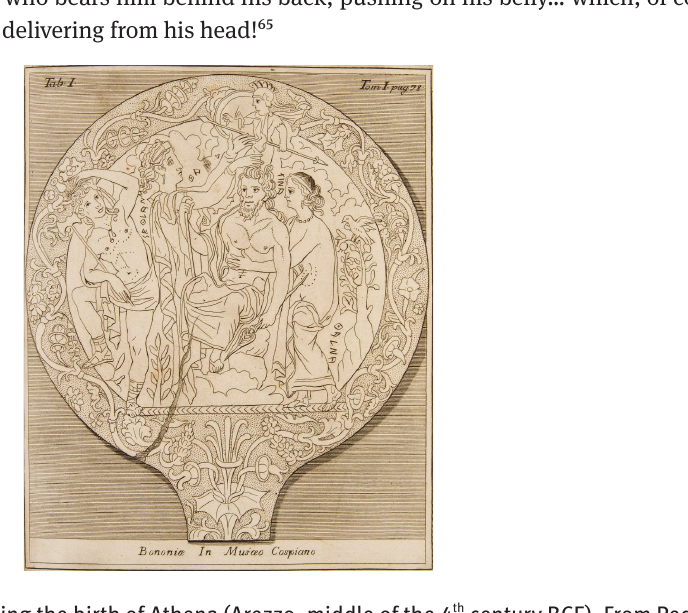
Figure 12. Etruscan mirror depicting the birth of Athena (Arezzo, middle of the 4 th century BCE). From Pedrucci, “Maternità e allattamento”, 32, fig.